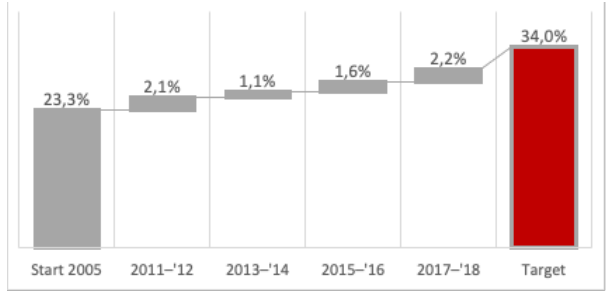
Figure 9. Austria—energy consumption trend. Source: https://ec.europa.eu/eurostat/web/energy/ data/shares, accessed on 28 June 2021.